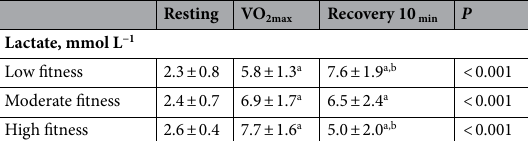
Resting VO 2max Recovery 10 min